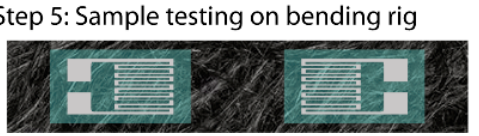
Figure 3. Illustration of the process steps using inkjet printing to integrate the strain sensor into the carbon fibre composite.